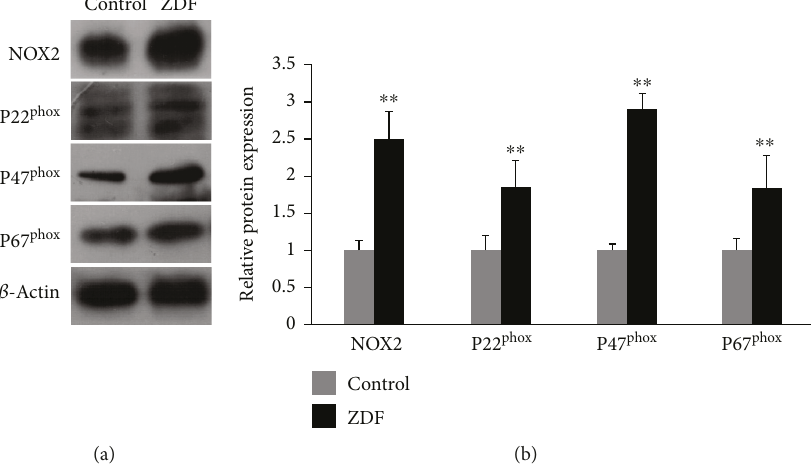
Figure 2: Protein expression of NOX2, P22 phox , P47 phox , and P67 phox in the auditory cortex of rats in the ZDF and control groups. (a) Representative images showing protein expression of NOX2, P22 phox , P47 phox , and P67 phox in the auditory cortex of rats in the ZDF and control groups using Western blot. (b) Quanti fi cation of NOX2, P22 phox , P47 phox , and P67 phox protein expression in the auditory cortex of rats in the ZDF and control groups. Data are expressed as mean ± SD ( n = 4 ). ∗∗ P < 0 01 .